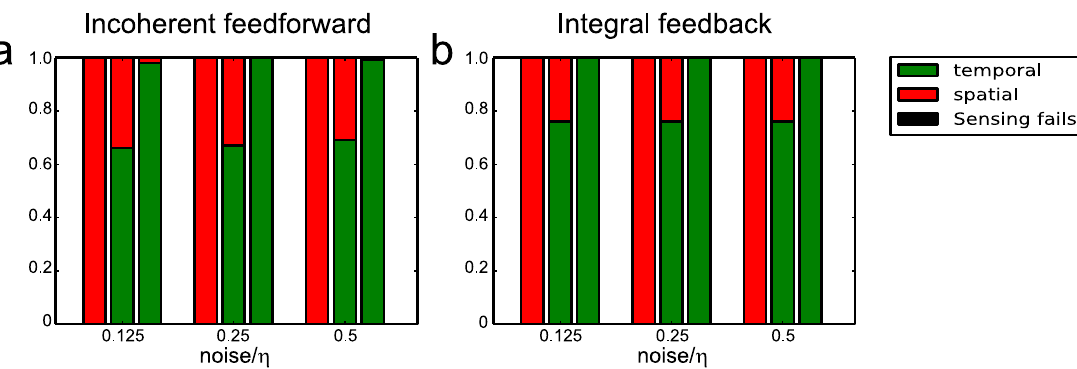
Fig 7. Internal noise does not affect sensing choice. Fraction of parameters that chose temporal sensing (green), spatial sensing (red) and failure in sensing (black) at different amount of noise, ν , for β = 0.25 (first column), β = 1.0 (second column) and β = 4.0 (third column) for incoherent feedforward circuit (a) and negative integral feedback circuit